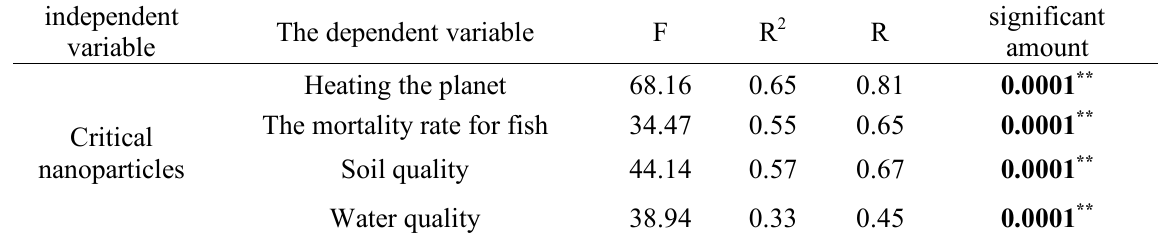
Table 5 . Evaluation of the effect of nanoparticles on the variable petrochemical critical environmental resources